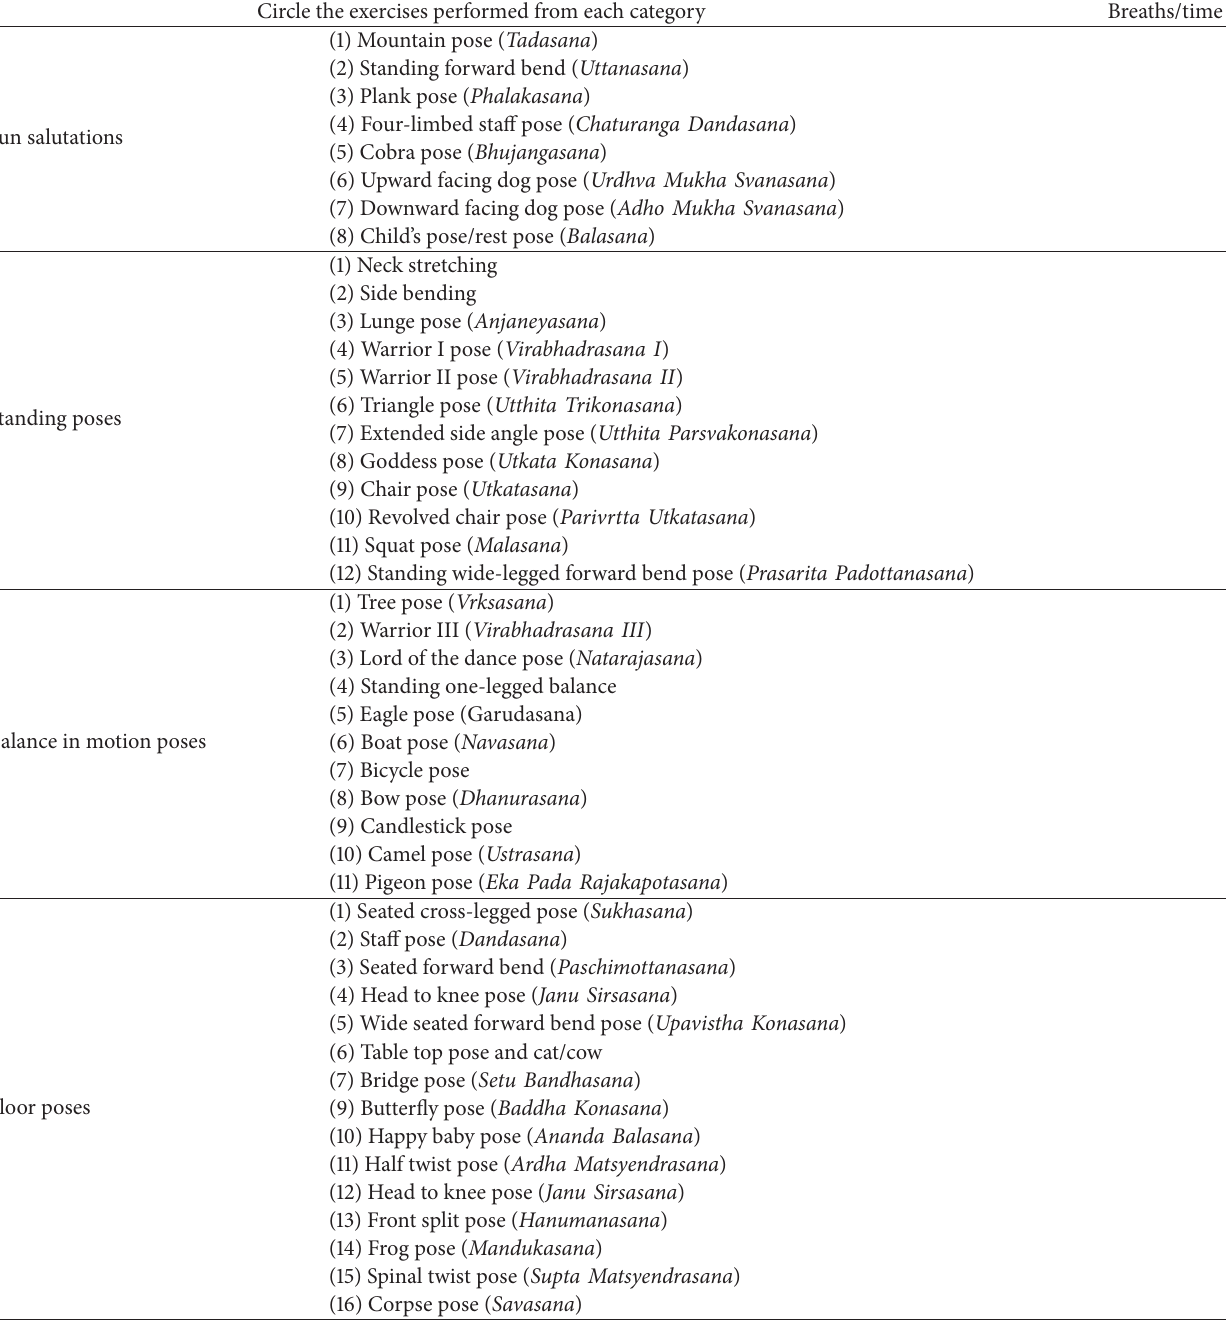
Table 3: Stretching exercise